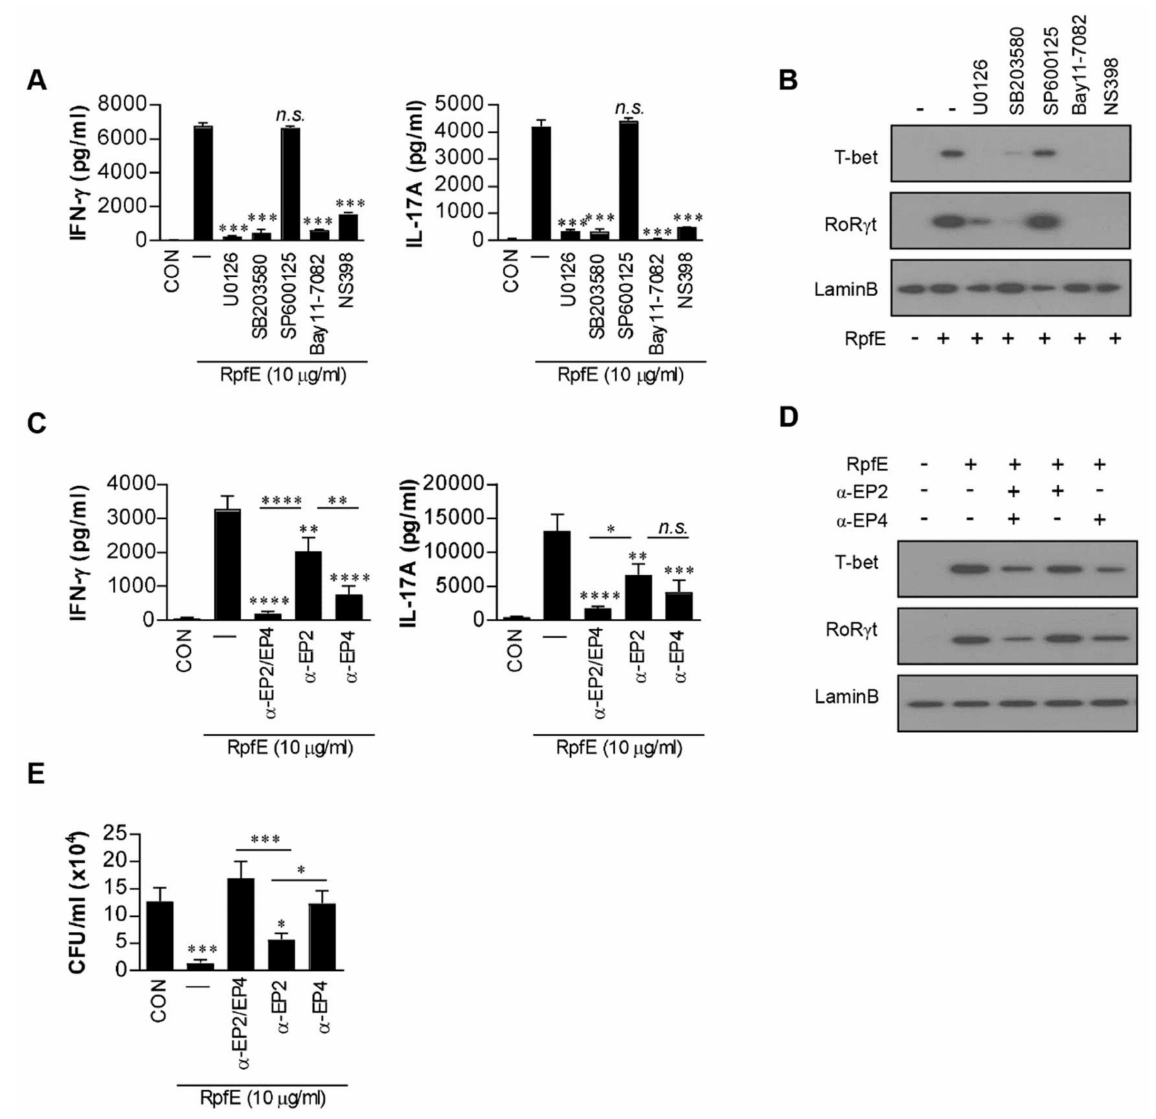
Figure 2. Prostaglandin E2 (PGE2) produced by RpfE-activated dendritic cells (DCs) induces Th1/Th17 differentiation via the EP4 receptor. ( A , B ) CD4 + T cells were isolated using MACS from Mtb-infected mice splenocytes and co-cultured for 72 h with dendritic cells (DCs) treated with pharmacological inhibitors for 1 h prior to treatment with 10 µ g/mL RpfE. ( A ) IFN- γ or IL-17A production in T cells co-cultured with RpfE-treated DCs was determined using ELISA in triplicate ( n = 3). All data are expressed as the mean ± SD; *** p < 0.001 for treated samples compared to RpfE-treated DCs co-cultured with CD4 + T cells; n.s. , no significant difference. ( B ) The levels of T-bet and RoR γ t in T cells were assessed by immunoblotting using specific anti-T-bet and anti-RoR γ t monoclonal antibodies. ( C , D ) T cells in the presence or absence of neutralizing antibody (anti-EP2, anti-EP4, or anti-EP2/EP4) co-cultured with unstimulated DCs or RpfE-stimulated DCs for 3 days. ( C ) The cytokine levels in culture supernatants were determined using ELISA. ( D ) The cell lysates were analyzed by immunoblotting. “ α ” means neutralization antibody treatment. All data are expressed as the mean ± SD; * p < 0.05, ** p < 0.01, *** p < 0.001 and **** p < 0.0001 for treated samples compared to RpfE-treated DCs co-cultured with CD4 + T cells; n.s. , no significant difference. ( E ) T cells in the presence or absence of neutralizing antibody (anti-EP2, anti-EP4, or anti-EP2/EP4) activated with unstimulated DCs or RpfE-stimulated DCs at a DC:T cell ratio of 1:10 for 3 days were co-cultured with Mtb-infected bone marrow-derived macrophages (BMDMs). Intracellular Mtb growth in the BMDMs was determined after 3 days. All data are expressed as the mean ± SD; * p < 0.05 and *** p < 0.001 for treated samples compared to infected BMDM co-cultured with activated CD4 + T cells by RpfE-treated DCs; n.s. , no significant